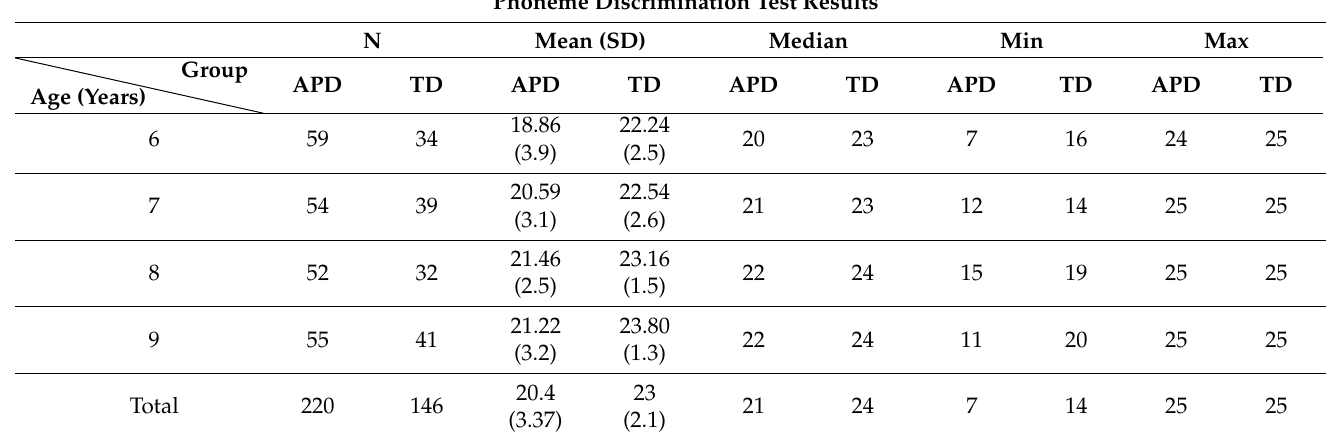
Table 5. Basic statistics describing the results of the Phoneme Discrimination Test (PDT), in APD and TD groups, by age.